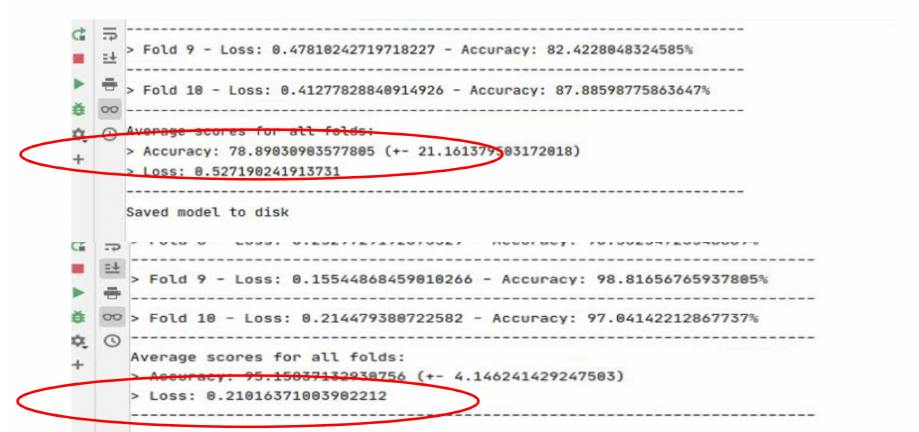
Figure 25. Comparative results of FFT vs. E-CPC for the deep learning CNN classification core over {3 anomaly signals} × {3 recorded systems} × {3 normal signals}.